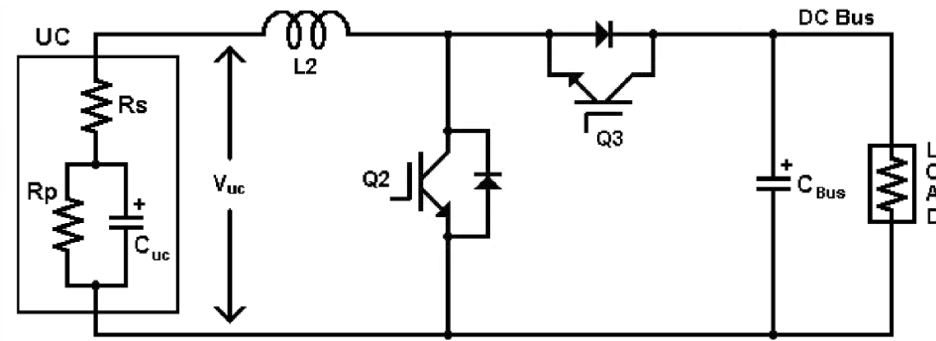
Figure 7. Non-isolated bidirectional DC/DC converter (BC) simulation model